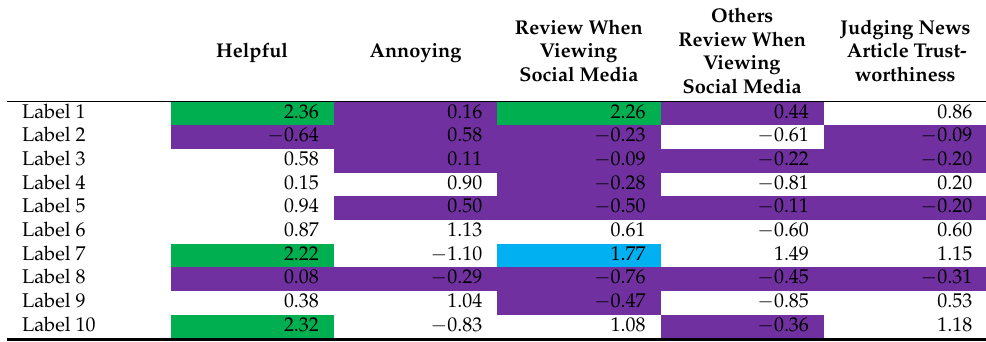
Table A3. Statistical significance calculations for Table 10